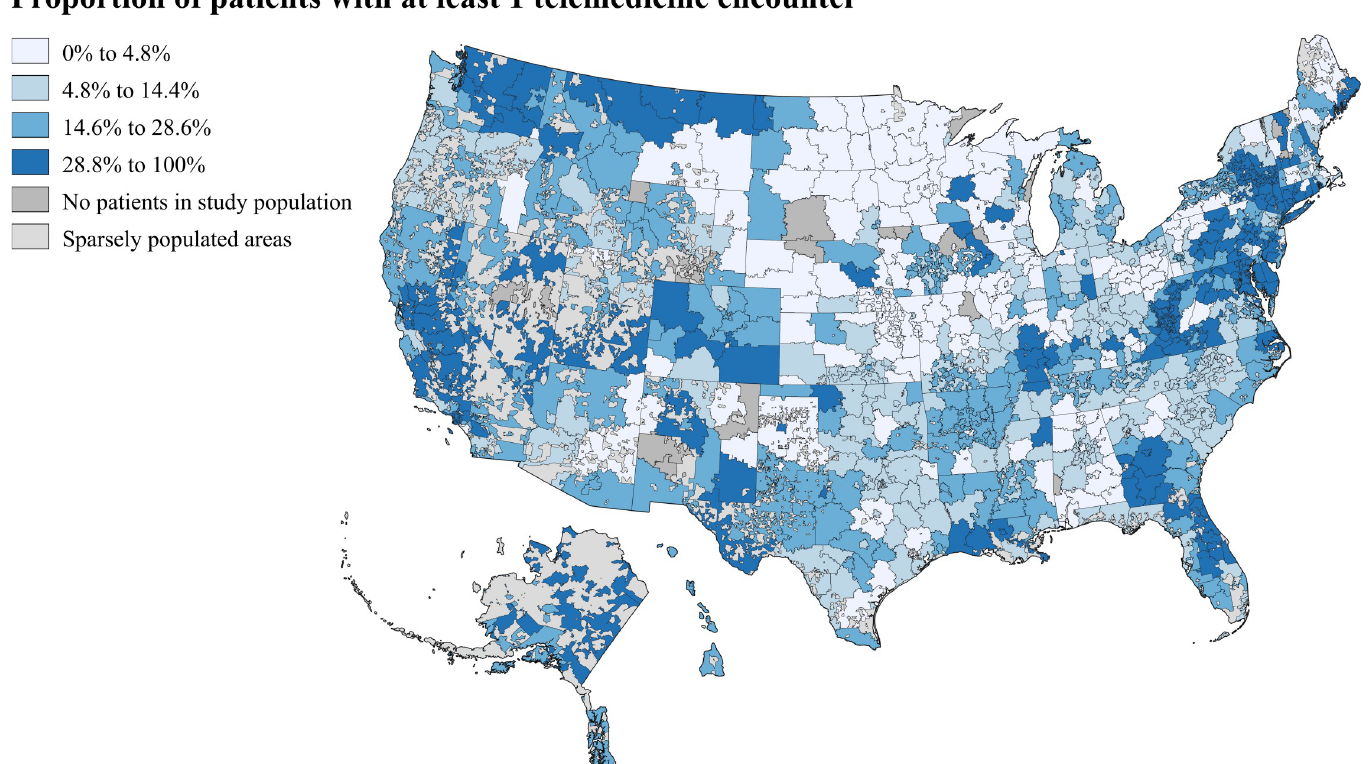
Fig 1. Proportion of patients with a telemedicine encounter (from March to December 2020) by 3-digit ZIP code. Figure based on 2019 ZIP code tabulation area shapefile created by US Bureau and Helathjump data [20]. Map projection based on modification of the US National Atlas Equal Area coordinate reference system. Proportion of patients in the study population with at least one telemedicine encounter during the study period in each 3-digit ZIP code divided into quartiles. Areas with no ZIP code tabulation area code provided by the US Census Bureau include sparsely populated areas and areas such as military facilities.